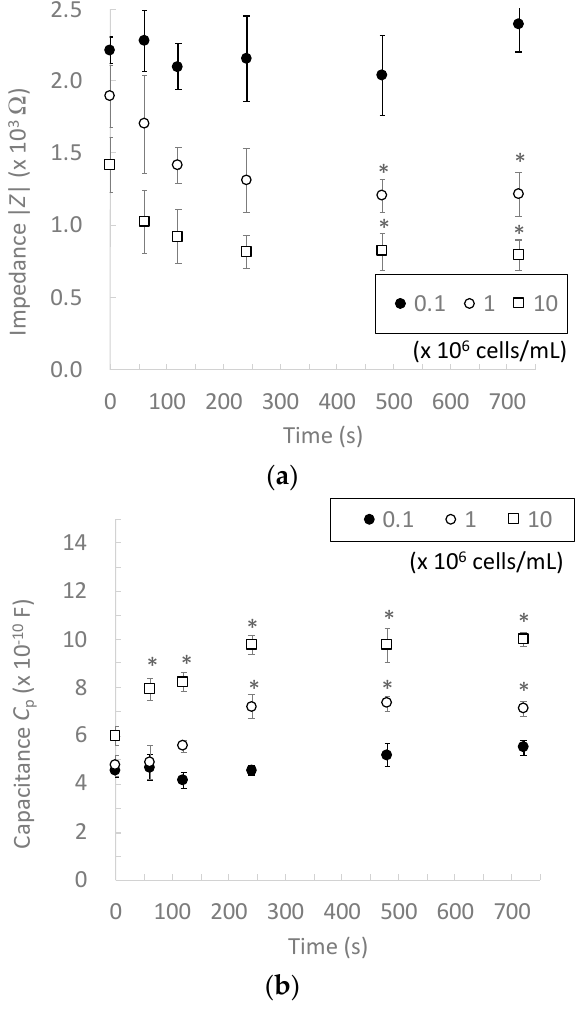
Figure 4. Changes in ( a ) electrical impedance and ( b ) capacitance of chondrocytes according to the cell sedimentation time at different cell concentrations (0.1, 1.0, and 10 × 10 6 cells/mL). Mean +/ − SD, n = 7. * indicates a significant difference in each value compared to that at 0 s, p < 0.05.